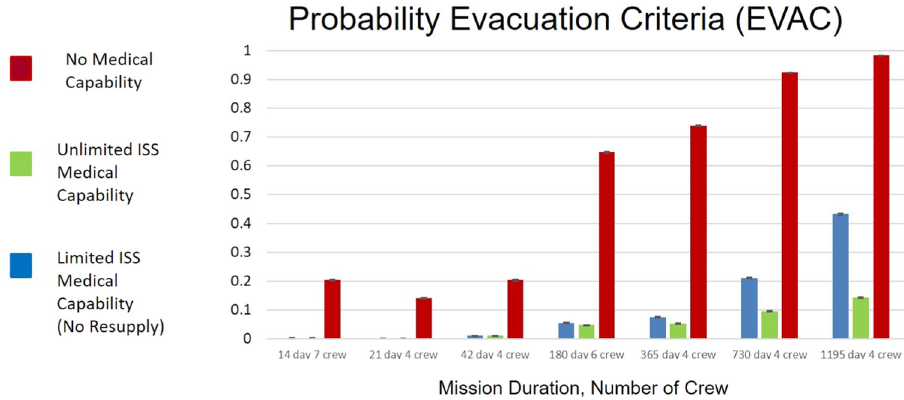
Fig. 4 Calculated likelihood that crew would consider evacuation if it were available due to medical conditions experienced in- fl ight. The 95% CIs is interpreted as the uncertainty estimated with respect to the data informing the 100 medical conditions and the PRA abstraction of the medical event timeline and end-states. As unaccounted uncertainties are not represented in this formulation or data representation, outcomes should be considered as representative of relative changes in risk rather than absolute risk assessments 14 . ISS International Space Station.